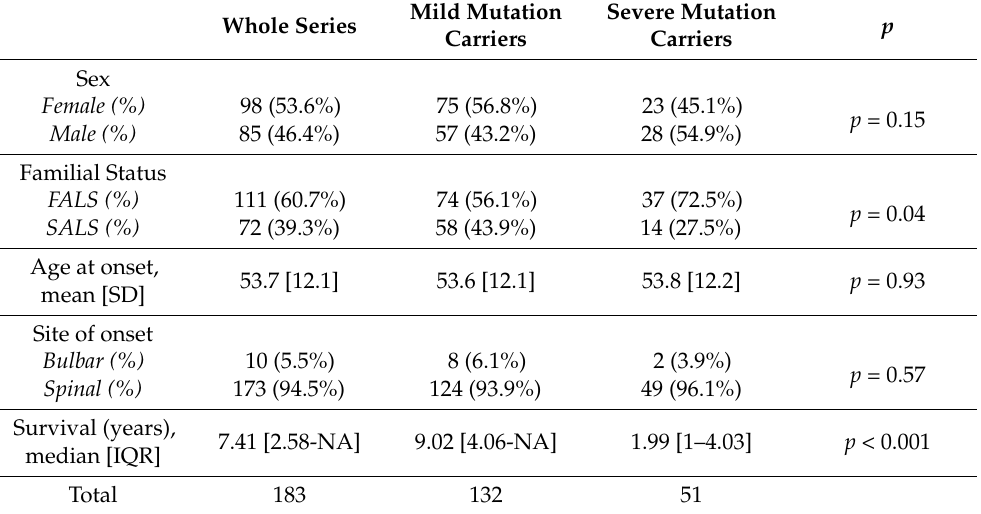
Table 2. Demographic and clinical characteristics of the whole series ( n = 183) and of the two groups (mild and severe mutation carriers). Mild Whole Series